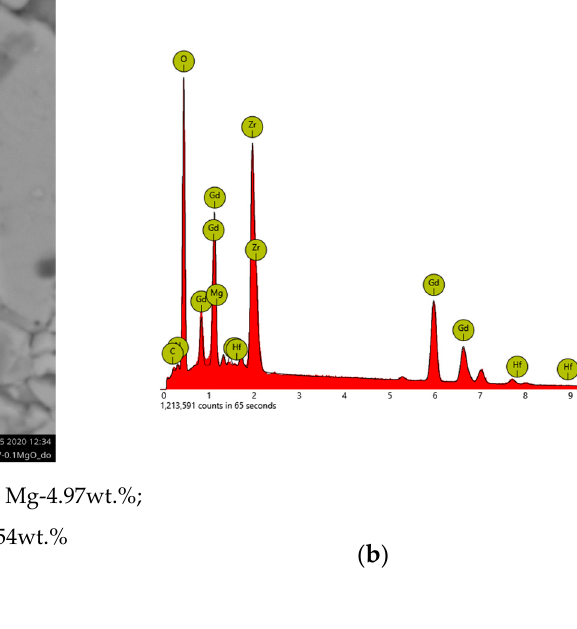
Figure 4. ( a ) SEM images of 0.90Gd 2 Zr 2 O 7 – 0.10MgO. ( b ) EDS spectra of 0.90Gd 2 Zr 2 O 7 – 0.10MgO in point 3. Table 3. The relative density of Gd 2 Zr 2 O 7 and (1- x )Gd 2 Zr 2 O 7 · x MgO samples.